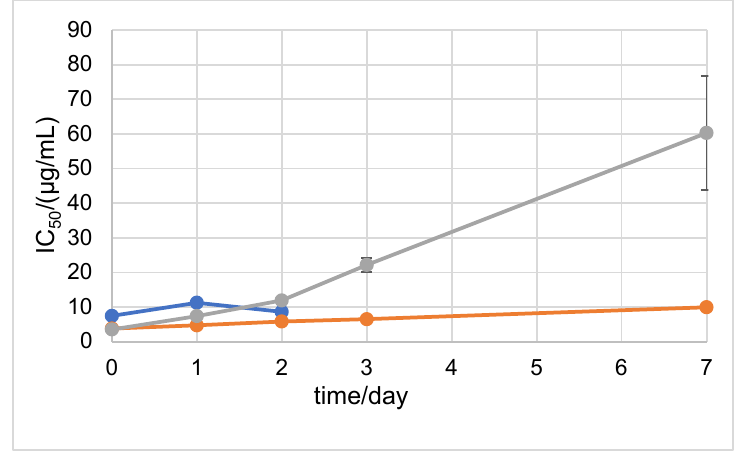
Figure 6. DPPH antioxidant stability of AA, NH 2 AA (D1), and CH 3 NHAA (D2) after 0, 1, 2, 3, and 7 days of incubation at 20 °C in the dark (after 7 days, all constituents decomposed). Results are expressed as µg/mL ± standard deviation (SD). D1 is shown in orange, D2 in blue, and AA in gray.